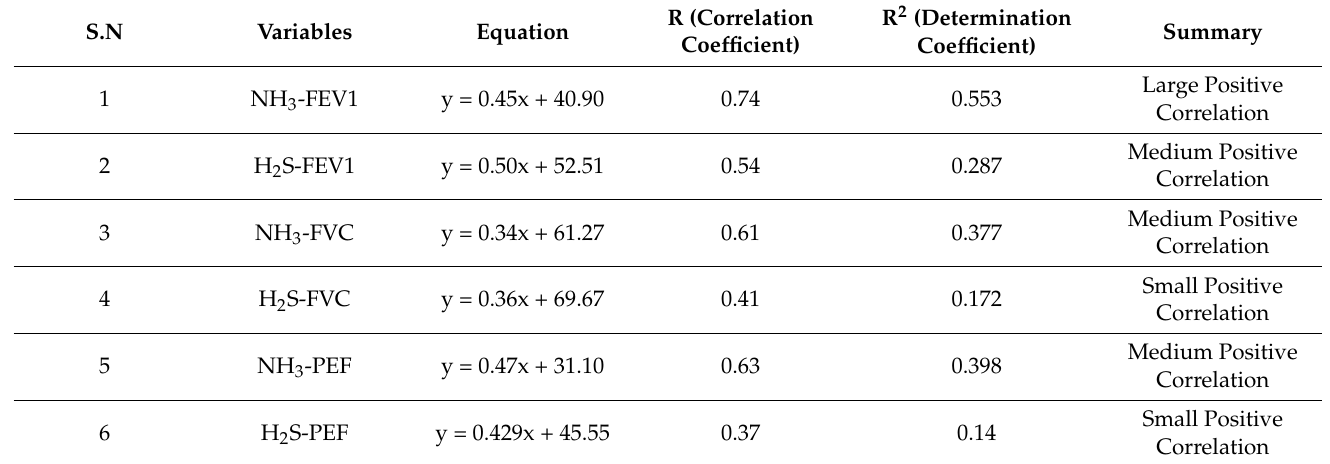
Table 3. Pearson Linear Regression Analysis of Exhaled Breath variables and Lung Function Test